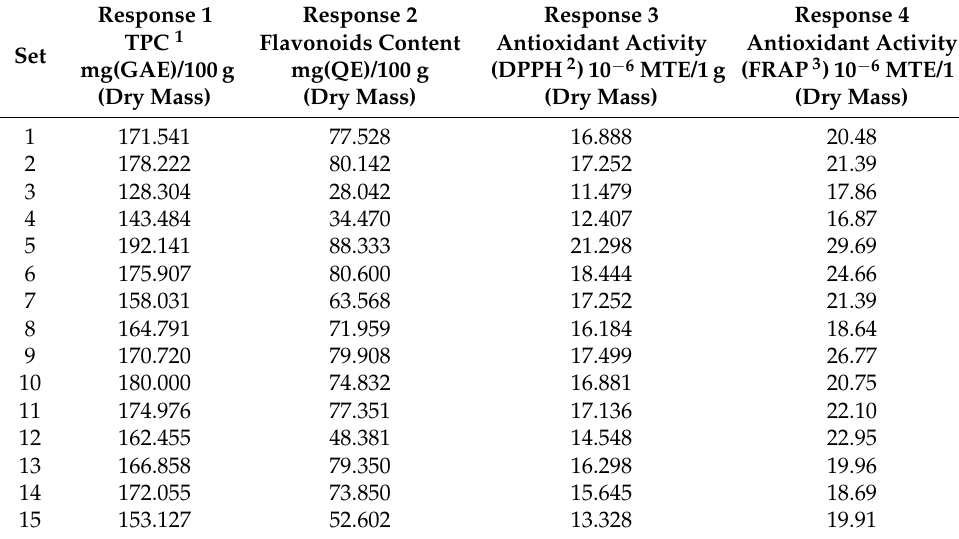
Table 4. Results of chemical